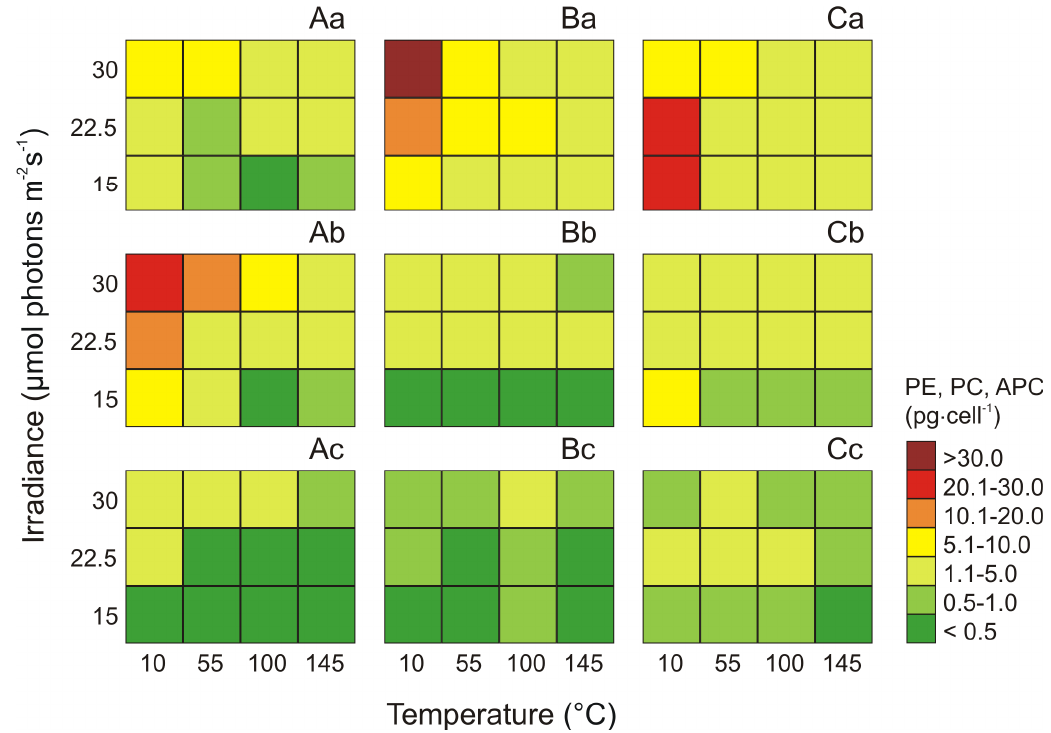
Figure 3. Changes in content (pg ∙ cell − 1 ) of PE ( a ), PC ( b ), and APC ( c ) obtained after 14 days of experiment for three phenotypes of Synechococcus sp.: Type 1 ( A ), Type 2 ( B ), Type 3a ( C ) under different irradiance ( μ mol photons m − 2 s − 1 ) and temperature (°C) conditions.